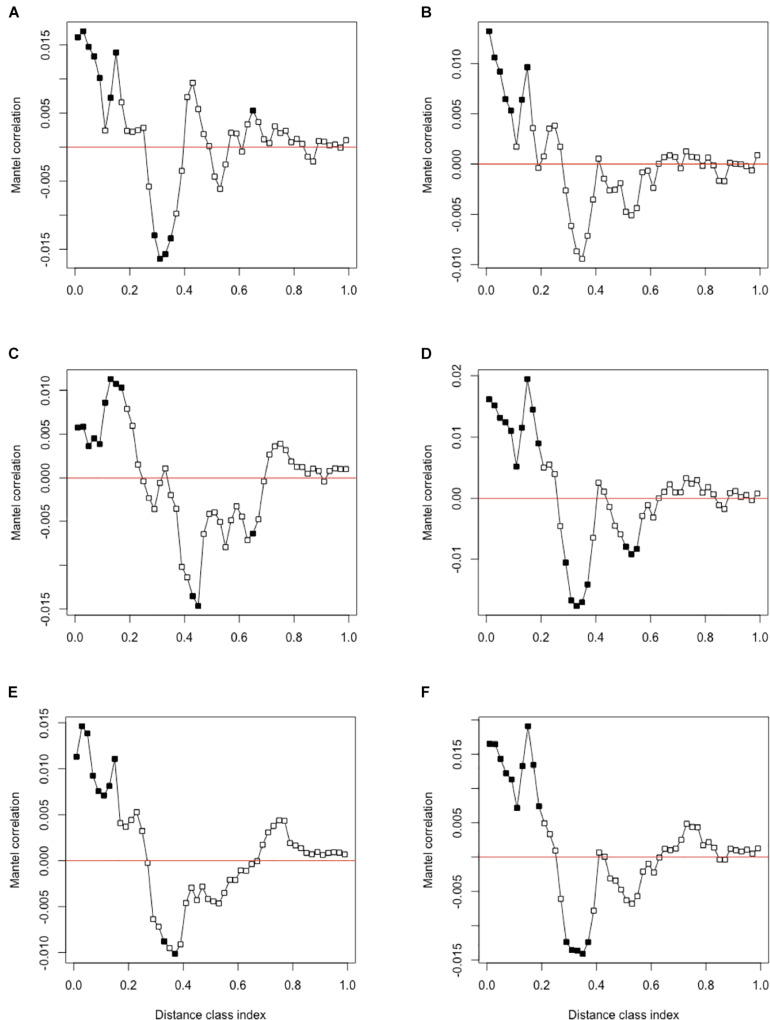
Mantel correlogram using Pearson’s correlation coefficient of between-ASV environmental optima and between-ASV phylogenetic distance for (A) pH, (B) % GWC, (C) % nitrogen, (D) % carbon, (E) C:N ratio, and (F) combined abiotic variables. Significant correlations (P < 0.05, solid circles) indicate phylogenetic signal in ASV ecological niche for the associated distance class. Significant positive correlations indicate that ecological similarity among ASVs is higher than expected by chance within the distance class. Alternatively, significant negative correlations indicate that ASVs are more ecologically dissimilar than expected by chance (Borcard and Legendre, 2012).